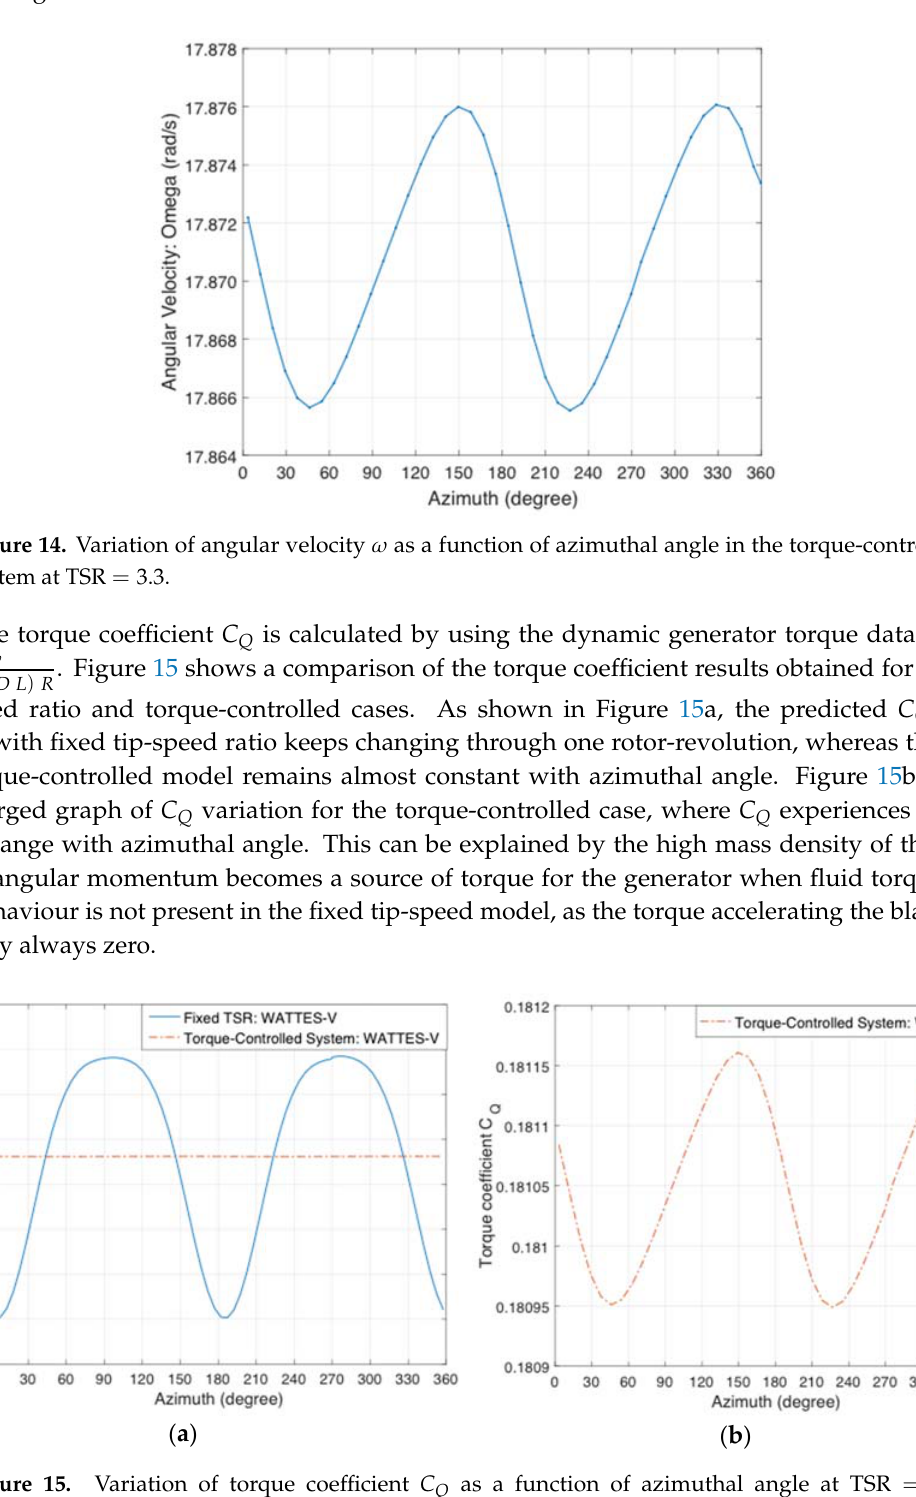
Figure 15. Variation of torque coefficient 𝐶 (cid:3018) as a function of azimuthal angle at TSR (cid:3404) 3.3 : ( a ) Comparison between results from the model with fixed TSR and its torque ‐ controlled counterpart; ( b ) Enlarged zone of 𝐶 (cid:3018) variation in the torque ‐ controlled model.